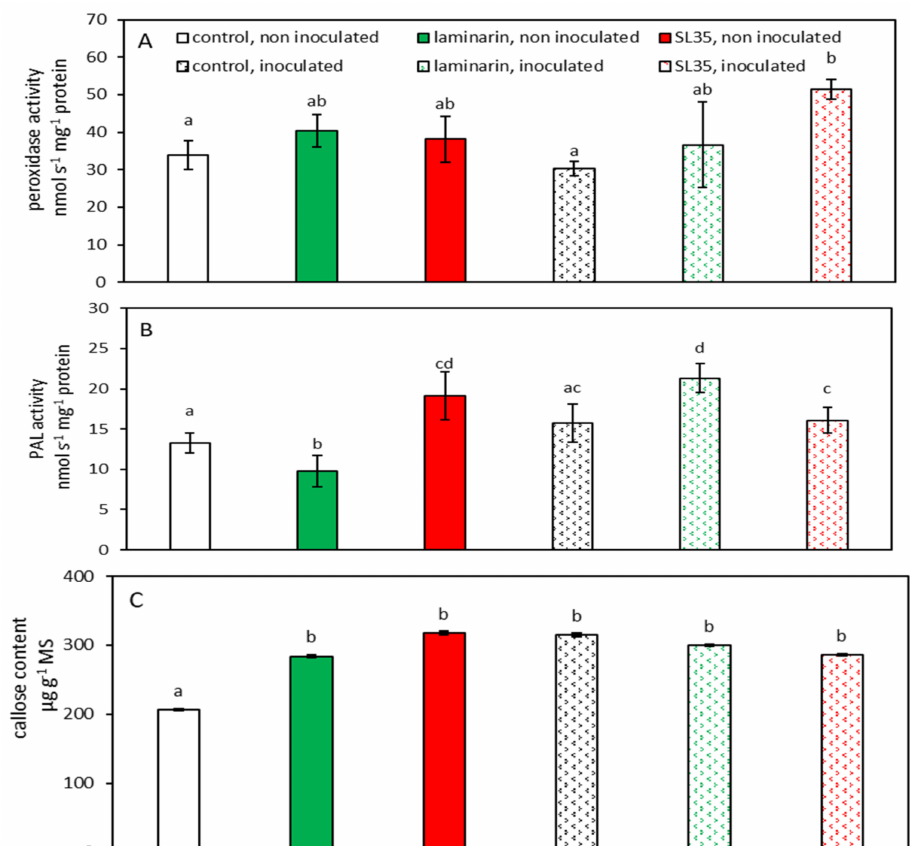
Figure 2. Peroxidase ( A ) and PAL ( B ) specific activities and callose content ( C ) determined in tomato leaves after treatment with SL35 (50 mg L − 1 ) or laminarin (days 1, 3 and 5). At day 8, inoculation by B. cinerea was applied or not (non-inoculated). All samples were collected at day 15. Peroxidase values are means of 15 samples ± SE and Kruskal Wallis test was performed. PAL values are means of 15 samples ± SD and one-way ANOVA was performed. Callose values are mean of 3 samples ± SD and one-way ANOVA was performed. Different letters indicate significant differences ( p <